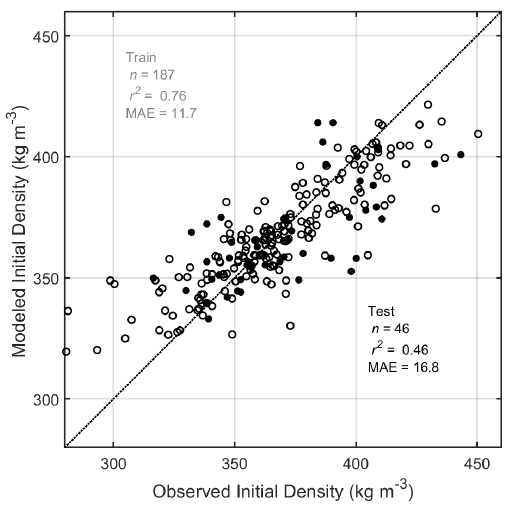
Figure 4. Comparison of observed and modeled initial densities. Solid circles indicate that they were not used in the final model de- velopment and represent an independent testing data set, whereas open circles represent the training partition used to build the Gaus- sian process regression model (see Sect. 2.1.5). The statistics in black are in reference to the solid circles only (testing partition), and those in gray are in reference to the open circles (training parti-